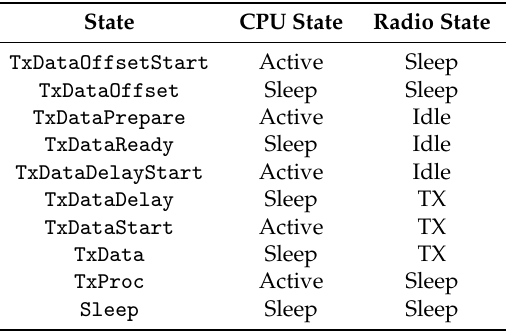
Table 3. States in a TxData